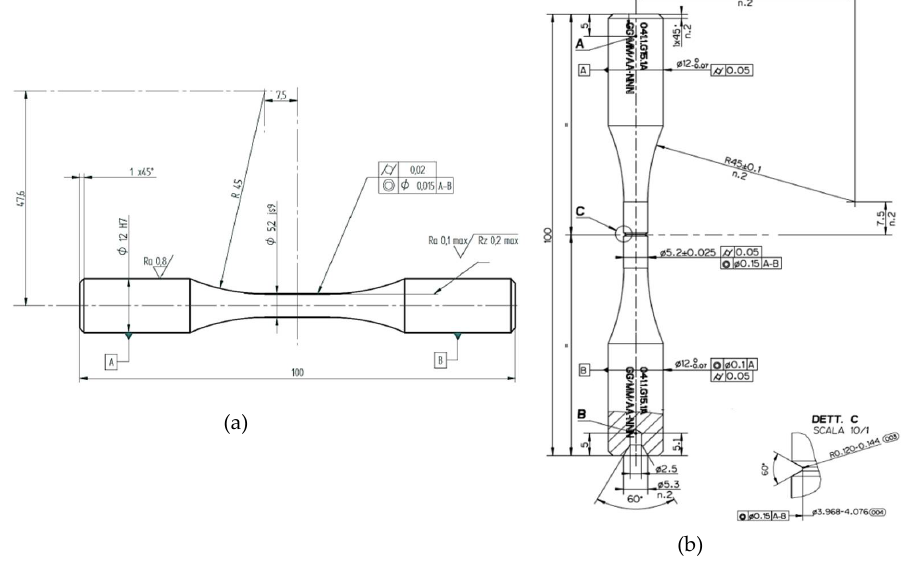
Figure 2. Shape and dimensions (mm) of the rotating bending fatigue test specimens: ( a ) unnotched and ( b ) notched (in this figure the commas has been used as decimal sign).